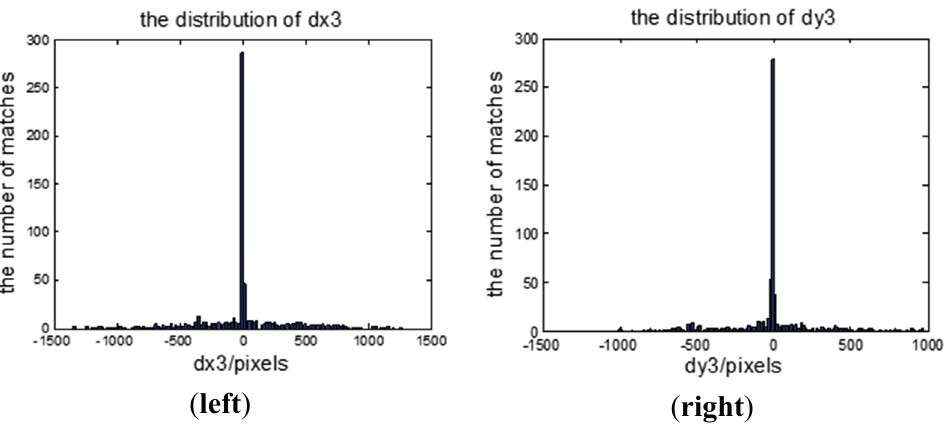
Figure 5. The matches’ coordinate displacements; ( left ) the distribution of dx 3 ; ( right ) the distribution of dy 3